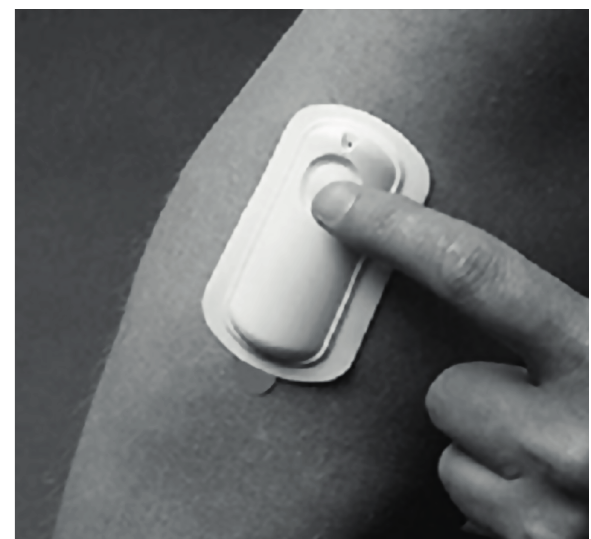
Figure 4 - Iontophoresis device applied to the forearm with digital activation through push-button button Source: Subramony et al. (45).